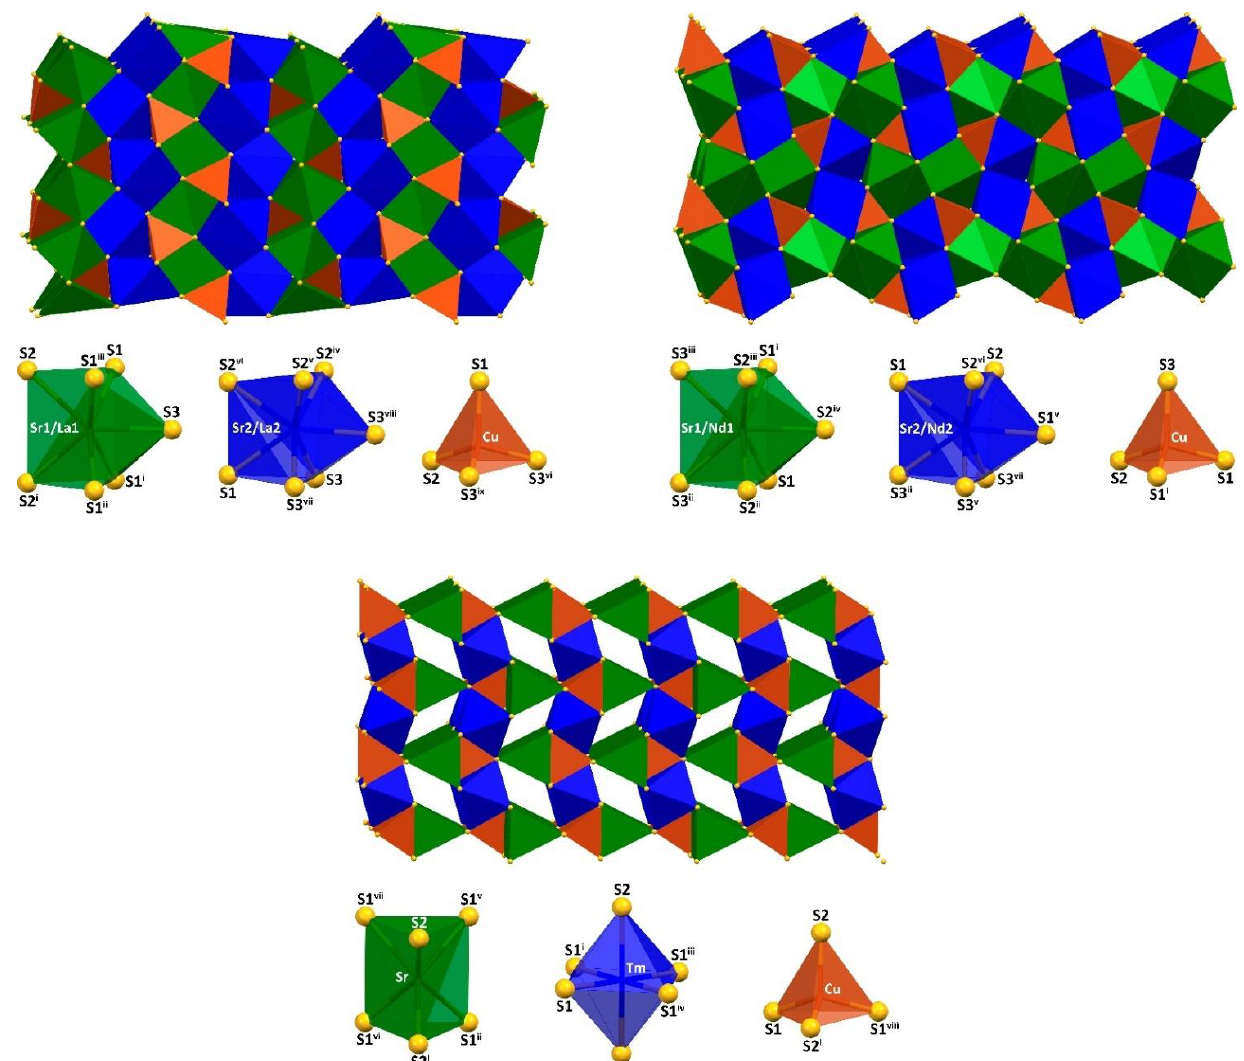
Figure 1. View of the crystal structures of SrLnCuS 3 (Ln = La, top-left; Nd, top-right, Tm, bottom) together with the coordination polyhedra formed by the metal ions. Color code: green polyhedron = (Sr1/La1)S 7 , (Sr1/Nd1)S 7 and SrS 6 ; blue polyhedron = (Sr2/La2)S 7 , (Sr2/Nd2)S 7 and TmS 6 ; burnt orange polyhedron = CuS 4 . Symmetry codes for SrLaCuS 3 : (i) x , – 1 + y , z ; (ii) 1/2 + x , − 1/2 − y , 1/2 − z ;